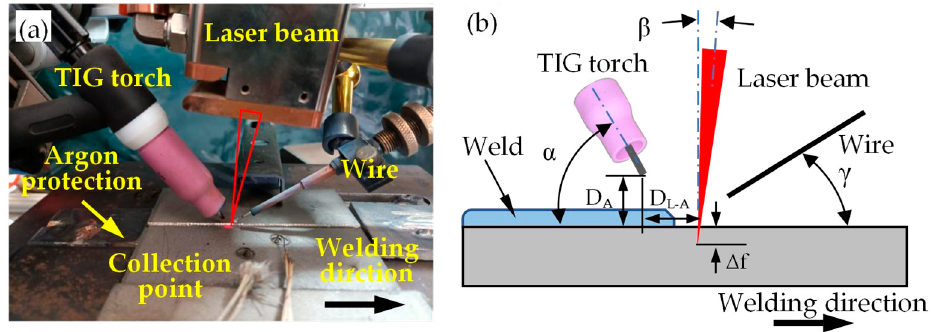
Figure 2. Laser–TIG hybrid welding system: ( a ) physical picture; ( b ) position relation of the laser, TIG torch, and welding wire.